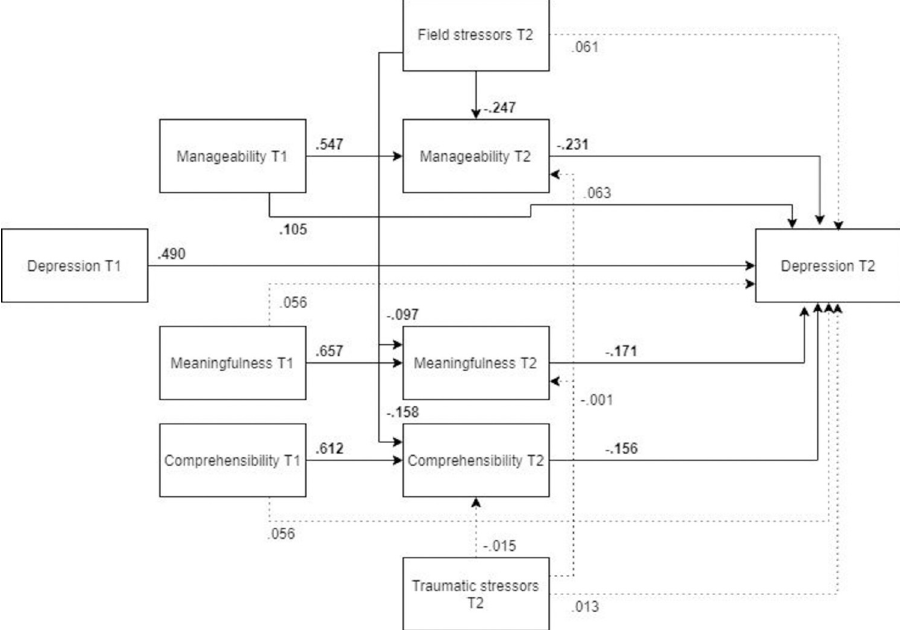
Fig 6. Tested structural equation model for depression.